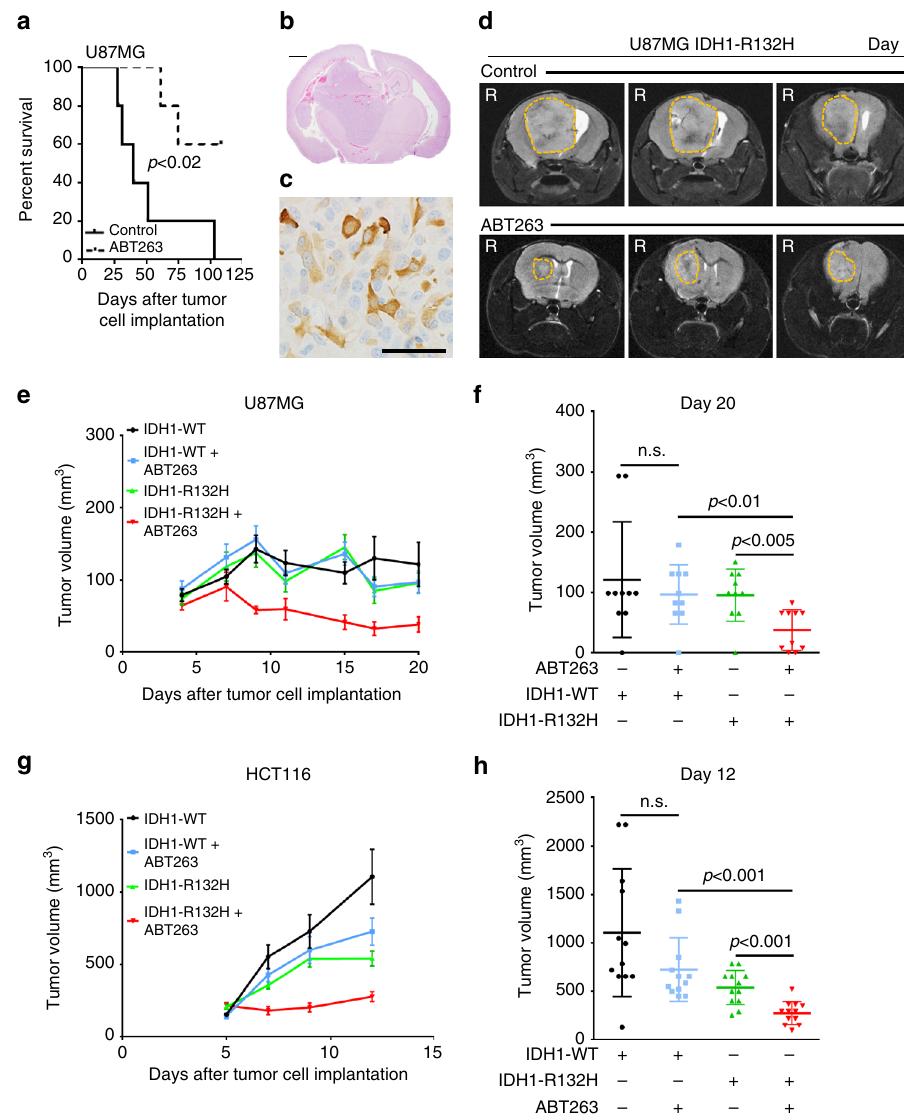
Fig. 6 ABT263 extends overall survival in an orthotopic glioblastoma model of IDH1-mutated U87MG. a U87MG IDH1-R132H cells were implanted into the right striatum of Nude mice. After establishment of tumors, two groups were formed and animals were treated with either vehicle ( n = 5; median survival = 40 days) or three times per week with 100 mg kg − 1 ABT263 ( n = 5; median survival > 108 days). Kaplan – Meier curves were generated for survival analysis. Comparison of survival curves was performed using Log-rank (Mantel-Cox) test. b Representative histological brain section from a vehicle-treated animal stained with H&E. Scale bar : 1 mm. c Immunohistochemical staining for IDH1-R132H in a tumor derived from U87MG IDH1-R132H cells. Magni fi cation, 40×. Scale bar : 50 µ m. d Representative MRI images of vehicle treated and ABT263-treated animals carrying U87MG IDH1-R132H tumors. e 1 × 10 6 U87MG IDH1-WT or IDH1-R132H cells were implanted subcutaneously. After tumor formation animals were randomized into two groups per IHD1 status ( n = 10 tumors per group) and treated intraperitoneally with vehicle or ABT263 100 mg kg − 1 3× per week. f Scatter plot indicating the tumor size of animals treated as described for E on day 20 after tumor cell implantation. g In all, 1 × 10 6 HCT116 IDH1-WT or IDH1-R132H colorectal cancer cells were implanted subcutaneously. After tumor formation animals were randomized into two groups per IDH1 status ( n = 12 tumors per group) and treated on 5 consecutive days intraperitoneally with vehicle or ABT263 75 mg kg − 1 . h Scatter plot indicating the tumor size of animals treated as described for h on day 12 after tumor cell implantation. e – h Data are presented as mean and SEM e , g /SD, f , h ). Student ’ s t -test was used for statistical analysis and a p -value of < 0.05 was considered statistically signi fi